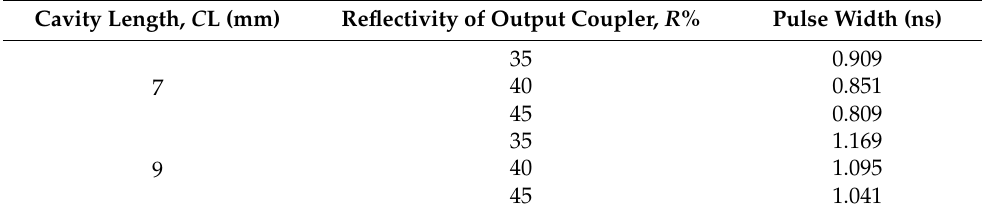
Table 2. Pulse width results for cavity lengths with 45% initial transmittance of Cr 4+ : YAG. Cavity Length, C L